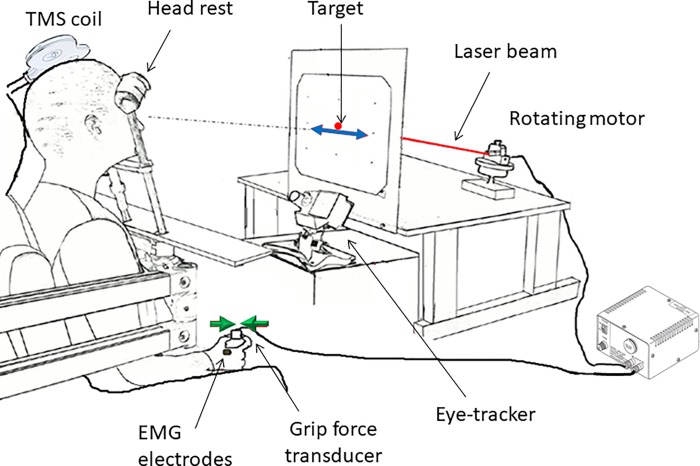
Schematic drawing of the experimental setup.All parts of this figure were drawn by the authors. This figure is similar but not identical to the original image in [15] and is therefore for illustrative purposes only. See text for more details.